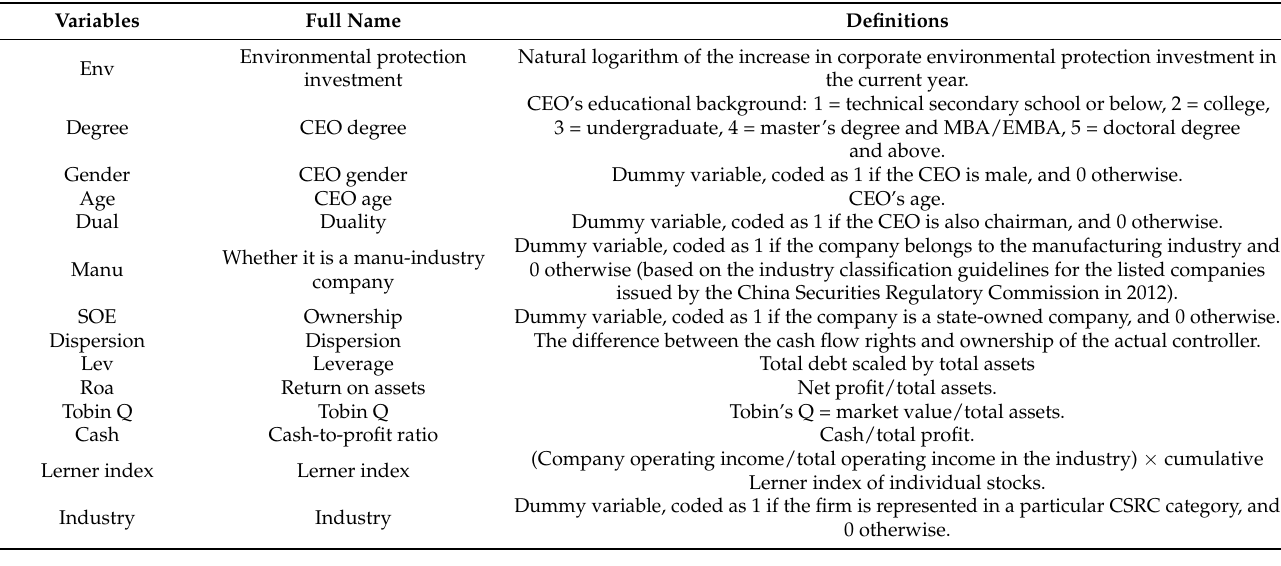
Table 1. The descriptions and measurements of the